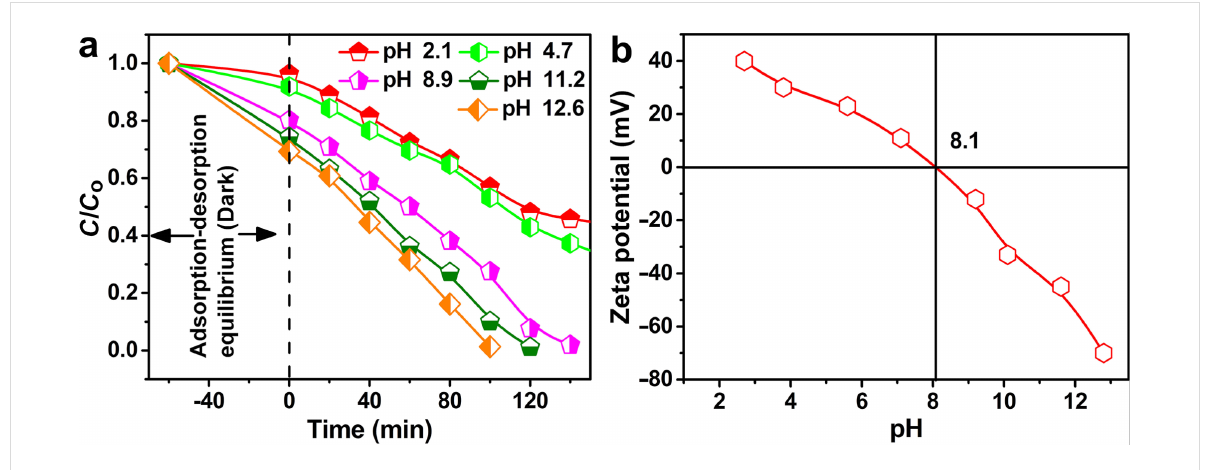
Figure 7: (a) MB degradation over the CuO/tourmaline-4:1 composite with different initial solution pH. Experimental conditions: [MB] 0 = 0.01 g L − 1 , [photocatalyst] 0 = 0.5 g L − 1 , volume = 100 mL, temperature = 25 °C. (b) Zeta potential of the CuO/tourmaline composite under various pH values.